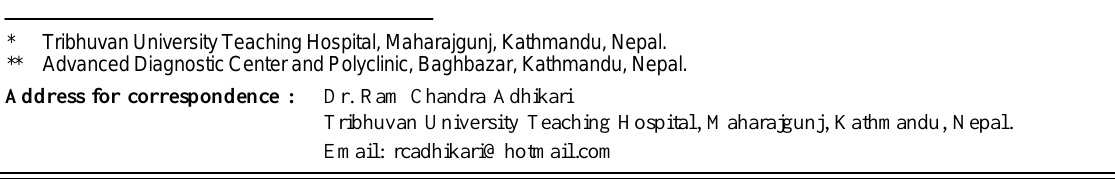
Fig. 1 : Gross specimen. The arrow shows exophytic mass.